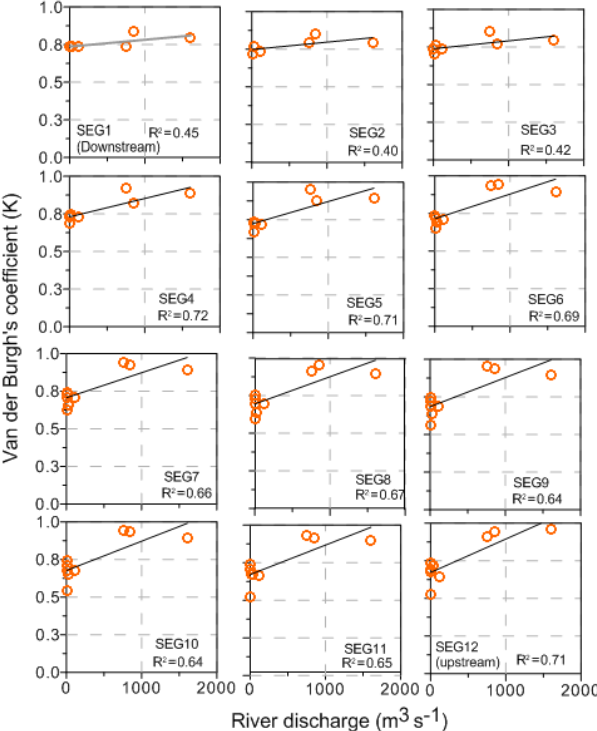
Figure 7. Plots of Van der Burgh’s coefficient ( K) against river dis- charge for different segments of the Pasur River estuary.